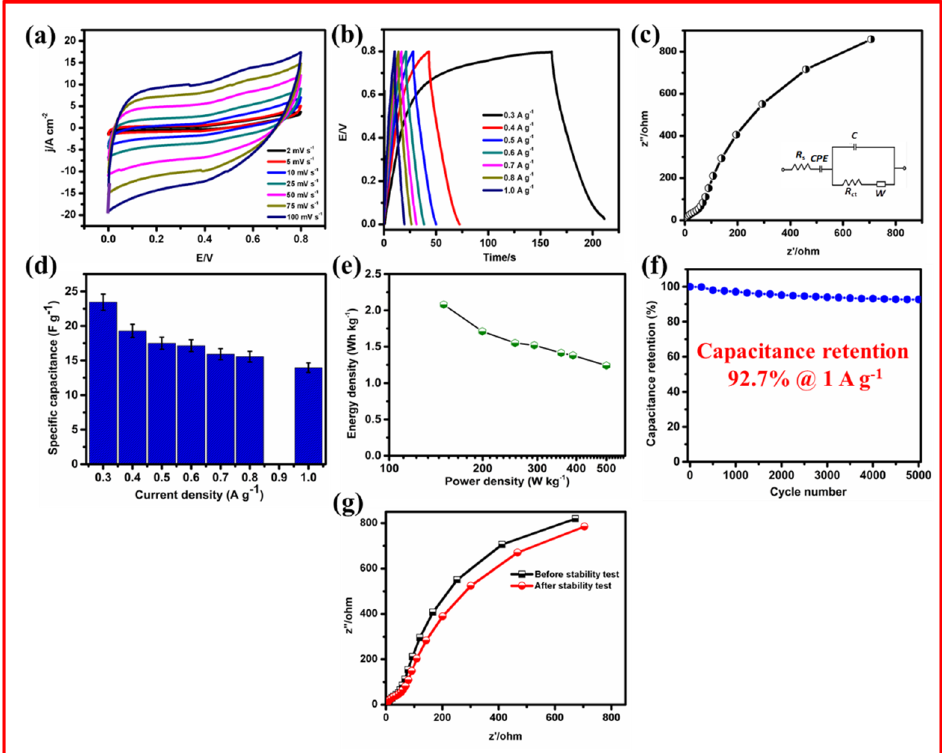
Figure 5. Performance of constructed symmetric supercapacitor (Ce(HPO 4 ) 2 .xH 2 O//Ce(HPO 4 ) 2 .xH 2 O)): CV profiles with various sweep rates ( a ); GCDs profiles with various current densities ( b ); EIS ( c ); plot of specific capacitance versus current density ( d ); Ragone plot ( e ); cyclic stability test over 5000 GCD profiles at 1 A g − 1 ( f ); and EIS for before and after stability studies ( g ). Inset of ( c ): equivalent circuit.